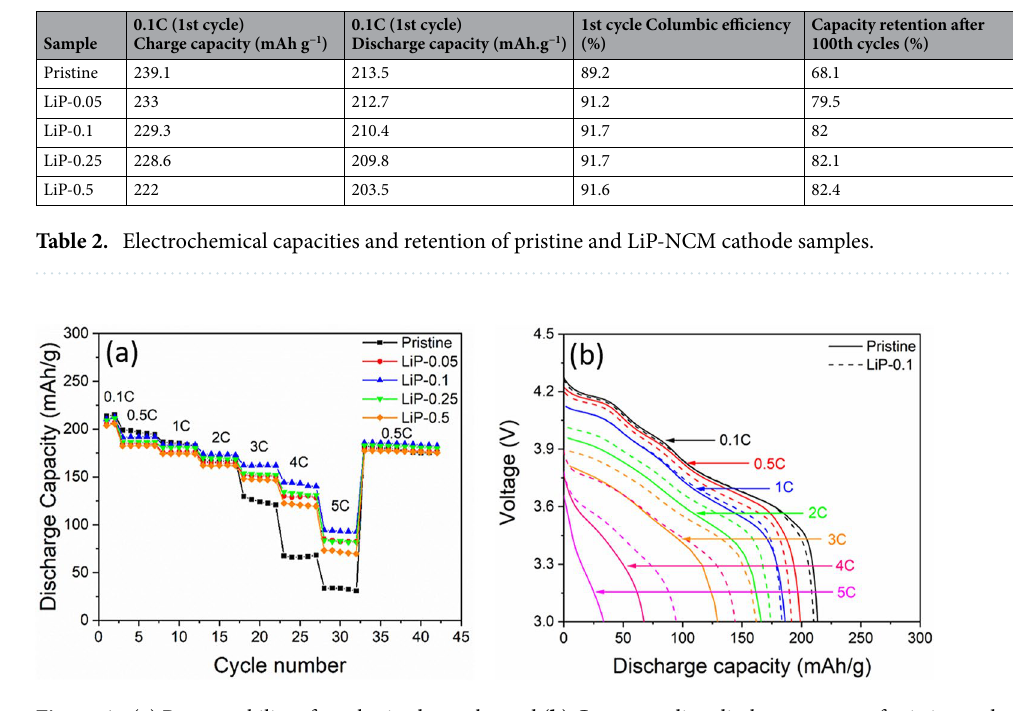
Figure 6. ( a ) Rate capability of synthesized samples and ( b ) Corresponding discharge curves of pristine and LiP-0.1 at various